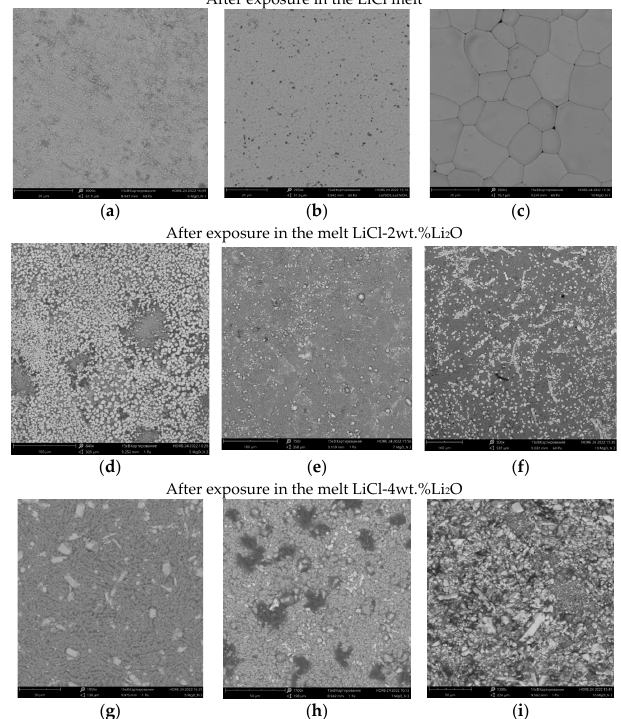
Figure 13. Scanning electron microscopy images of ( a ) 0.95Gd 2 Zr 2 O 7 -0.05MgO, ( b ) 0.93Gd 2 Zr 2 O 7 - 0.07MgO, and ( c ) 0.90Gd 2 Zr 2 O 7 -0.10MgO after exposure for 48 h in LiCl at a T = 650 °C. Scanning electron microscopy images of ( d ) 0.95Gd 2 Zr 2 O 7 -0.05MgO, ( e ) 0.93Gd 2 Zr 2 O 7 -0.07MgO, and ( f ) 0.90Gd 2 Zr 2 O 7 -0.10MgO after exposure for 48 h in a LiCl-2wt.%Li 2 O melt at T = 650 °C. Scanning electron microscopy images of ( g ) 0.95Gd 2 Zr 2 O 7 -0.05MgO, ( h ) 0.93Gd 2 Zr 2 O 7 -0.07MgO, and ( i ) 0.90Gd 2 Zr 2 O 7 -0.10MgO after exposure for 48 h in a LiCl-4 wt.%Li 2 O melt at T = 650 °C.